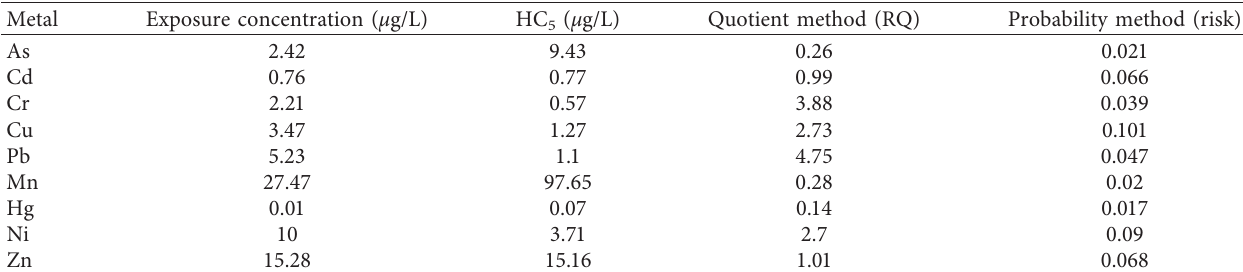
Table 3: Exposure and risk results of metals in Lake